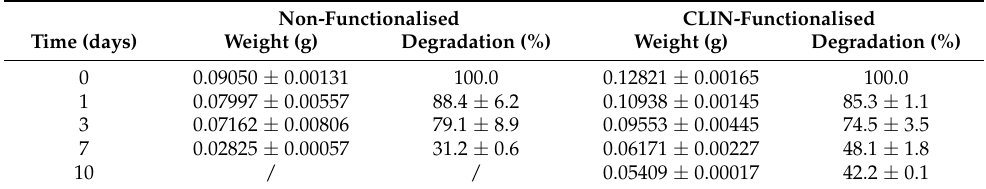
Table 4. The data for the plotting of the degradation curves in Figure 5b. The results are given as average values ± standard deviation for the replicate measurements.